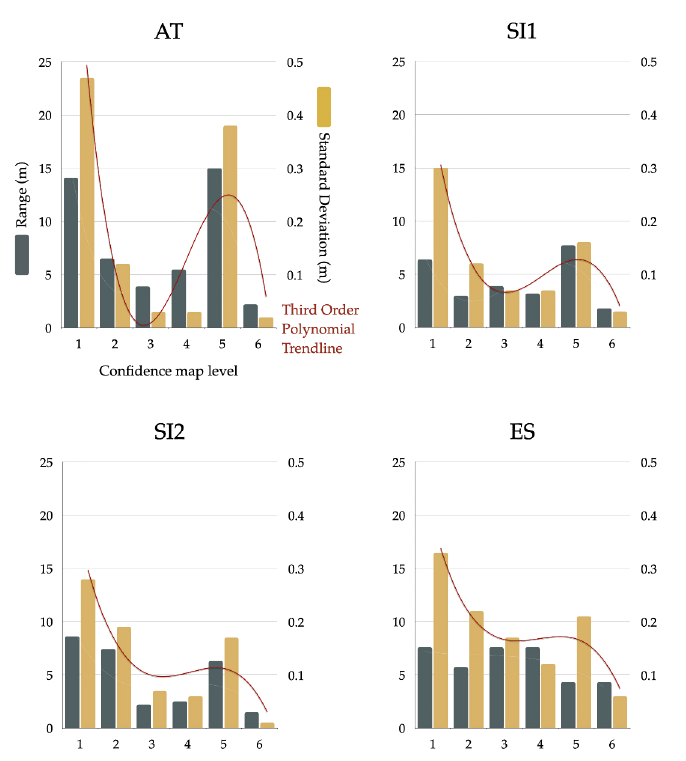
Figure 10. Zonal statistics of the absolute difference between DFMs interpolated with IDW and TLI (each calculated with default settings in Golden Software Surfer 19.2.x). Range and standard deviation within confidence map levels 1 to 6 are shown for each test site (calculated using ArcGIS 10.3 tool Zonal Statistics Table).